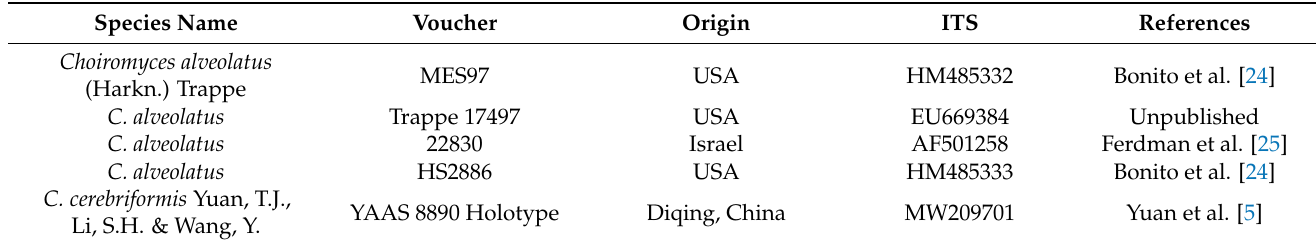
Table 1. Species name, voucher, origin, ITS, and references for